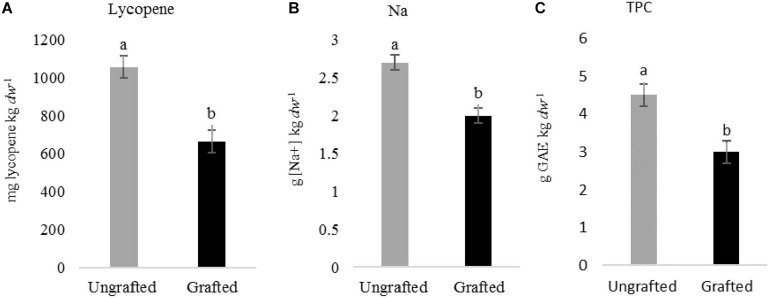
Effect of grafting on lycopene (A), sodium concentration [Na+] (B) and total phenolic compound (C) in tomato cv. Durinta fruits produced in spring 2016. Data are mean ± standard error (n = 5). Column with the same letter did not differ (P < 0.05) according to the non-parametric Wilcoxon test.